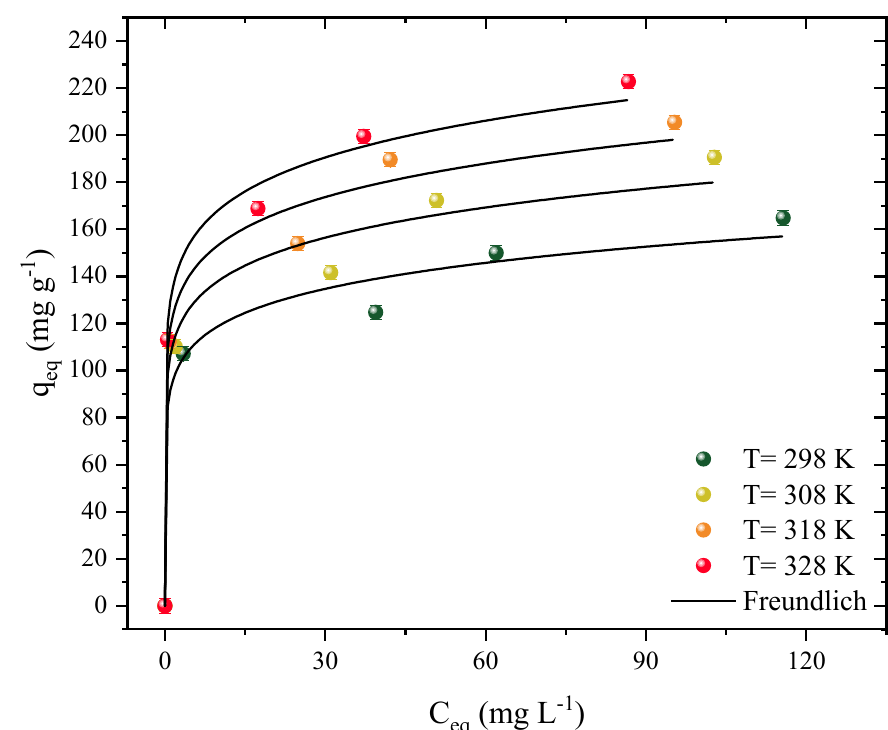
Figure 3. N 2 ads/des isotherms ( A ) and pore size distribution ( B ).